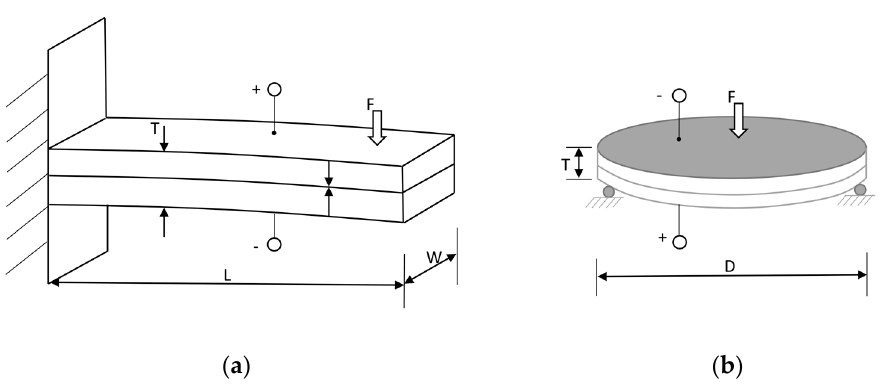
Figure 3. Recurring topologies for energy harvesters. ( a ) Rectangular form; ( b ) circular form [11].